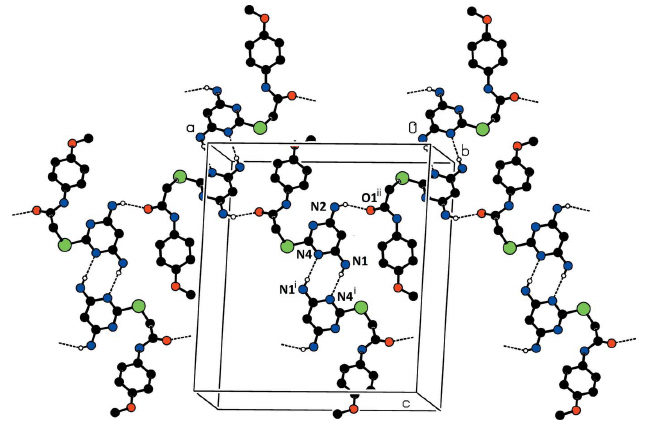
Figure 3 A packing diagram of the title compound, showing the C—H (cid:3)(cid:3)(cid:3) (cid:2) and N—H (cid:3)(cid:3)(cid:3) (cid:2) interactions (dashed lines). Hydrogen atoms not involved in these interactions have been omitted for clarity. [Symmetry codes: (iii) (cid:4) x , y (cid:4) 1 , (cid:4) z + 1 ; (vi) (cid:4) x + 1 , y (cid:4) 1 , z .] 2 2 2 2